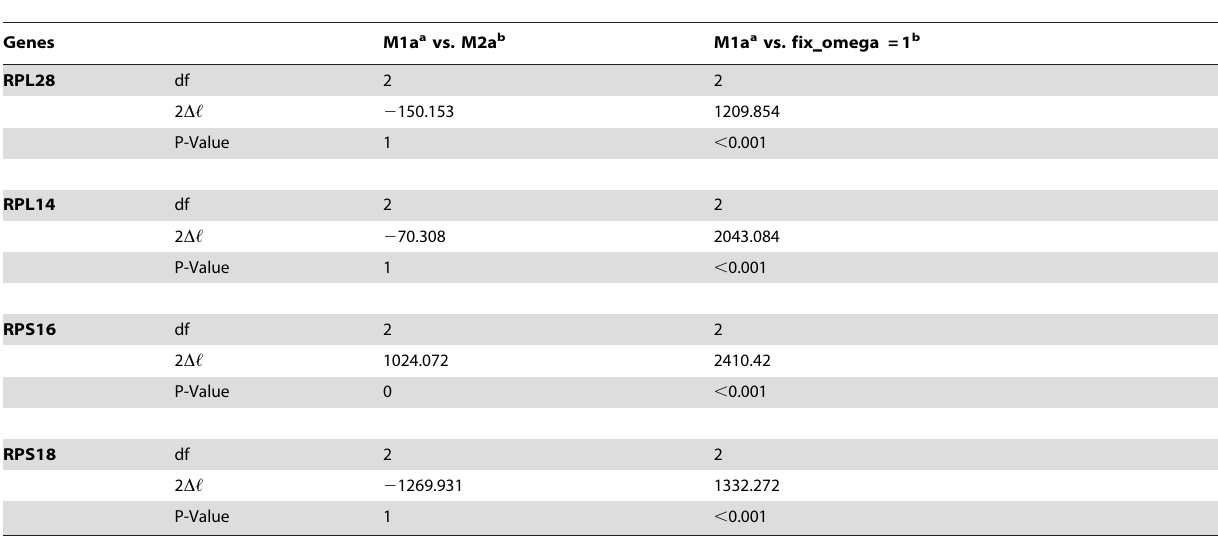
Table 1. Likelihood Ratio Test statistics (LRT) for random site models.